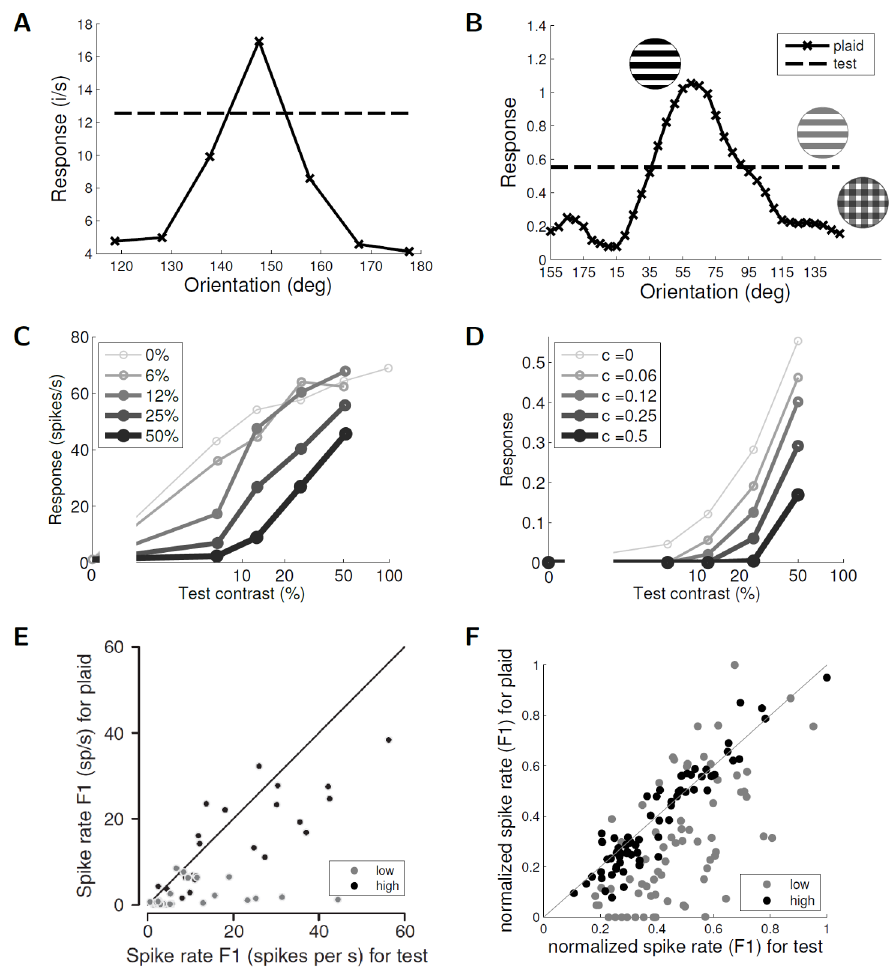
Figure 8. Cross orientation suppression. (A) A cat V1 simple cell demonstrates cross orientation suppression by responding with lower firing levels to an iso-oriented test grating if an ortho-oriented grating (mask) is superimposed (data replotted from [48], Figure 3(A)). The dashed line is the response to the iso-oriented test grating with no mask stimulus. (B) Cross orientation suppression exhibited by a sparse coding model neuron. Note the same dependence on the orientation of the mask that is seen in (A). (C) Contrast tuning curves of the test at different fixed mask contrast levels for a cat simple cell (data replotted from [50], Figure 2A). (D) Contrast tuning curves of the test for the same sparse coding model cell as in (B). Note again the same response modulation as in physiology despite the lack of contrast saturation in the model (see Discussions). (E) Measurement of modulation (F1) component of the response to a test grating alone vs. that with a superimposed orthogonal grating from a population of visual cortical neurons in cat (reprinted by permission from Macmillan Publishers Ltd: Nature Neuroscience, Figure 2b from [51]). The unity line represents where there is no suppression. The response at low test contrast is further away from the diagonal, suggesting more suppression in this regime. (F) Measurement of F1 response to a test grating alone vs. that with a superimposed orthogonal grating from the sparse coding model population. Note that just as in the physiology data, the model has the same general suppressive behavior, with increased suppression with lower test contrast.